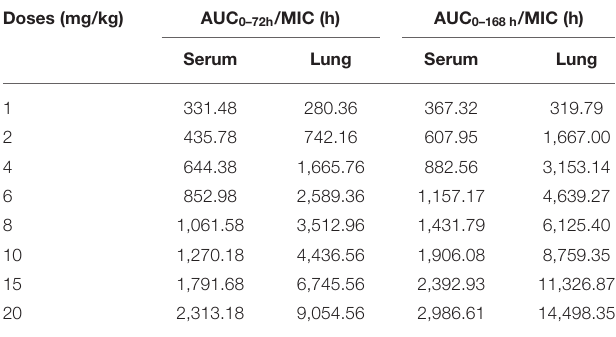
TABLE 5 | Different doses of AUC/MIC (0–72h or 0–168h) for serum and lung. Doses